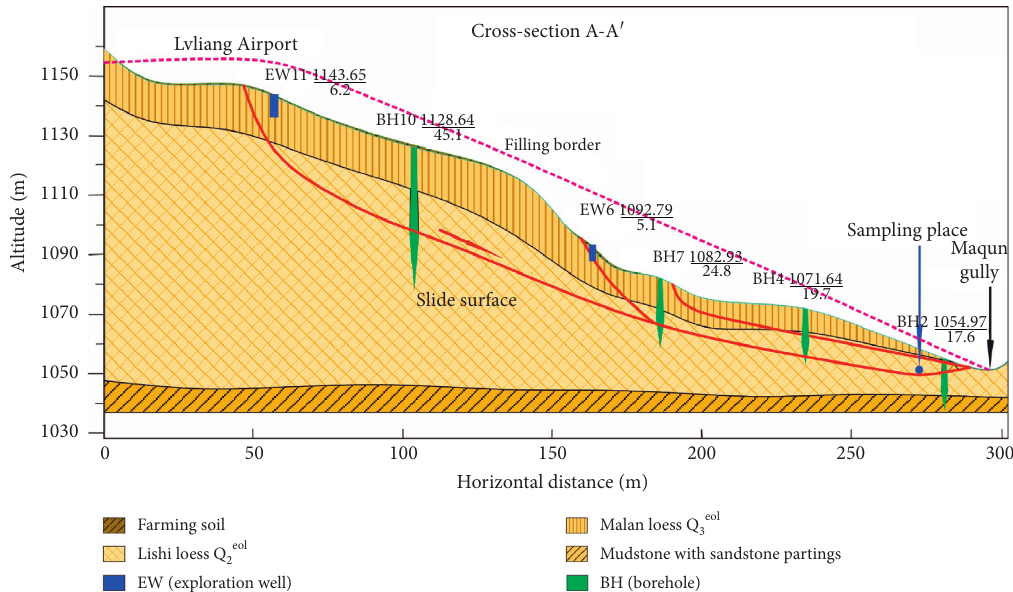
Figure 2: Longitudinal section of the landslide along line A-A ′ in Figure